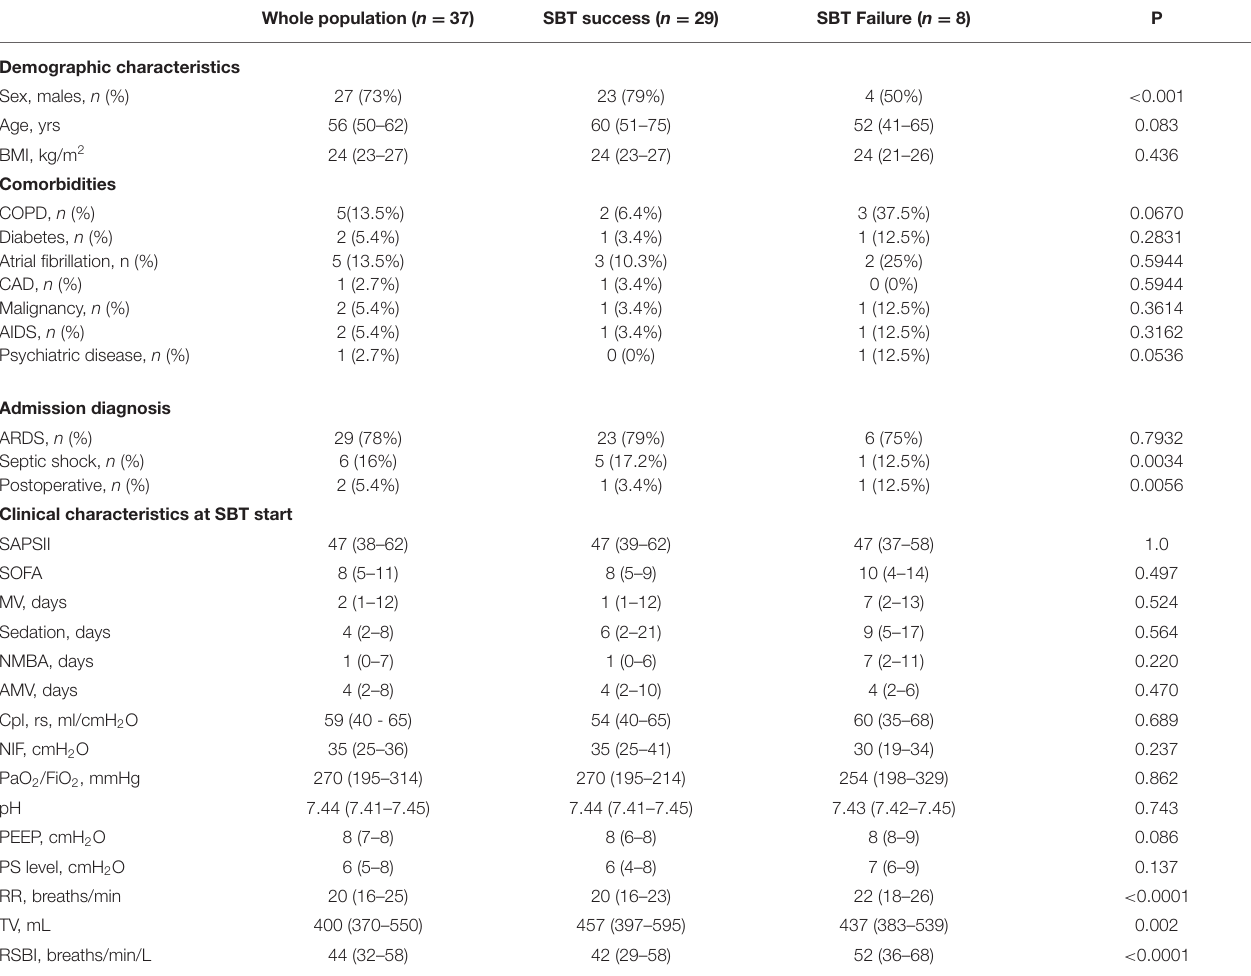
TABLE 1 | Baseline characteristics of the study population were stratified by success vs. failure of a spontaneous breathing trial (SBT). Data are referred to the study day. Whole population ( n = 37) SBT success ( n = 29) SBT Failure ( n =